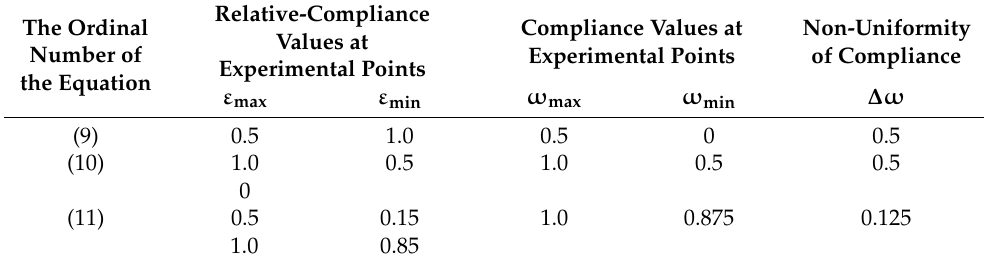
Table 1. Values of non-uniformity of compliance of the technological system along the machining